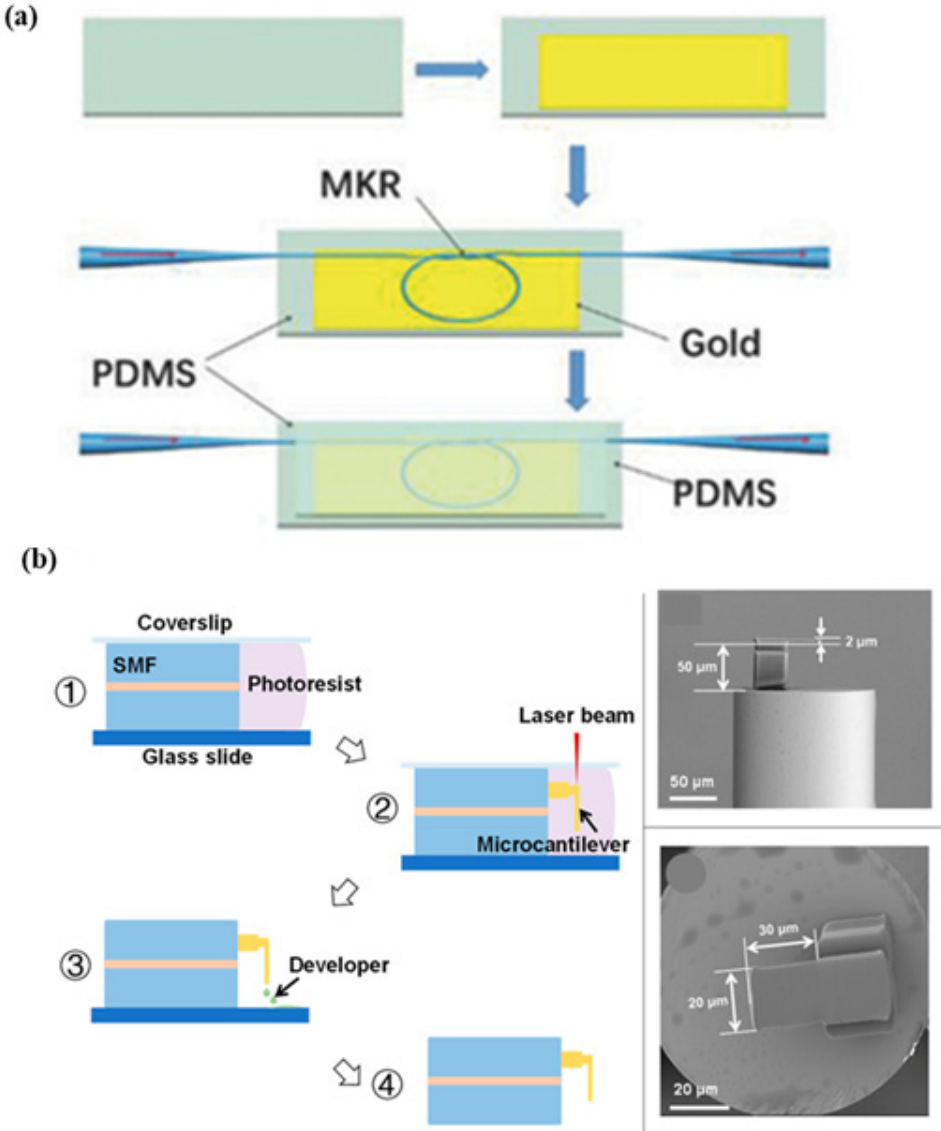
Figure 8. Schematic of various fiber-based wearable sensors. ( a ) Hetero-core optical fiber for respiration and heartbeat measurement. Reprinted with permission from Advanced Materials Technologies, Copyright 2018, Wiley [67]; ( b ) a respiration sensor using Fabry–Perot interferometry, fabrication steps of fiber-tip micro-cantilever that involve femtosecond laser and scanning electron microscopy of the fabricated wearable sensor. Reprinted with permission from Biosensors, Copyright 2018, MDPI [68].